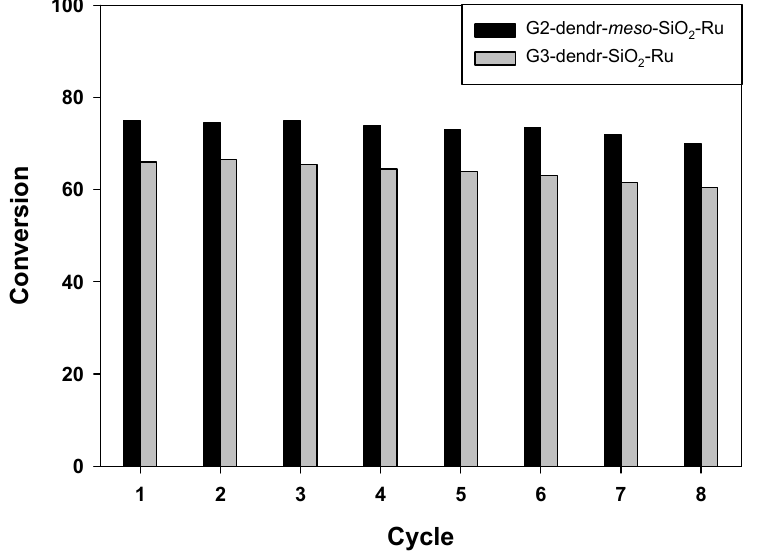
Figure 10. Recycling of porous silica-immobilized dendrimer-based Ru catalysts in phenol hydrogenation. Reaction conditions are: 5 mg of catalyst, 300 mg of phenol, 300 µL of water, at 80 °C, 3 MPa of H 2 for 2 h. PhOH/Ru ≈ 1843 for G2-dendr- meso -SiO 2 -Ru and 887 for G3-dendr-SiO 2 -Ru.